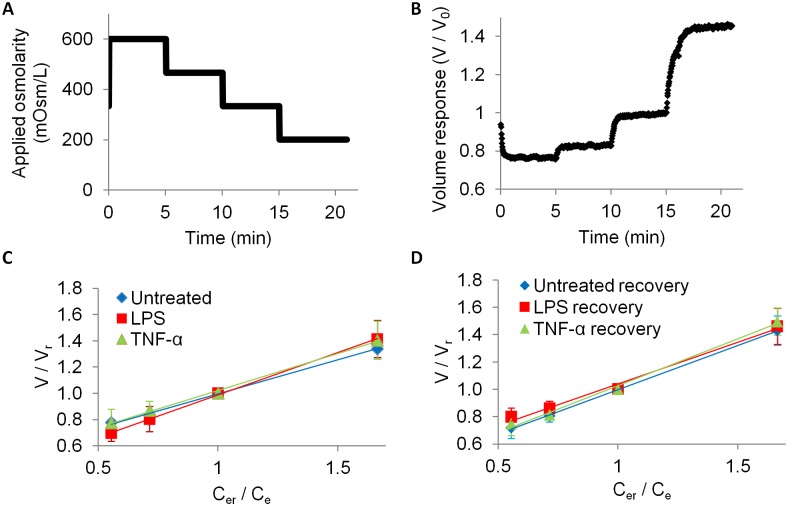
Osmotic loading regime, representative volume-response curve, and equilibrium volume-concentration responses.(A) Osmolarity was applied in a step-wise fashion using decreasing concentrations of NaCl solutions. Each osmotic load was maintained for approximately 5 minutes to allow the cell volume change to reach equilibrium. (B) Representative time-dependent volume of an untreated cell. (C, D) Equilibrium volume (V), normalized by reference volume (Vr), is plotted as a function of applied external reference osmolarity (cer) over current external osmolarity (ce) for cells at (C) 24 hour and (D) 7-day recovery time points (n = 7–12 cells per group). The reference osmolarity and associated volume were taken at 333 mOsm/L equilibrium.